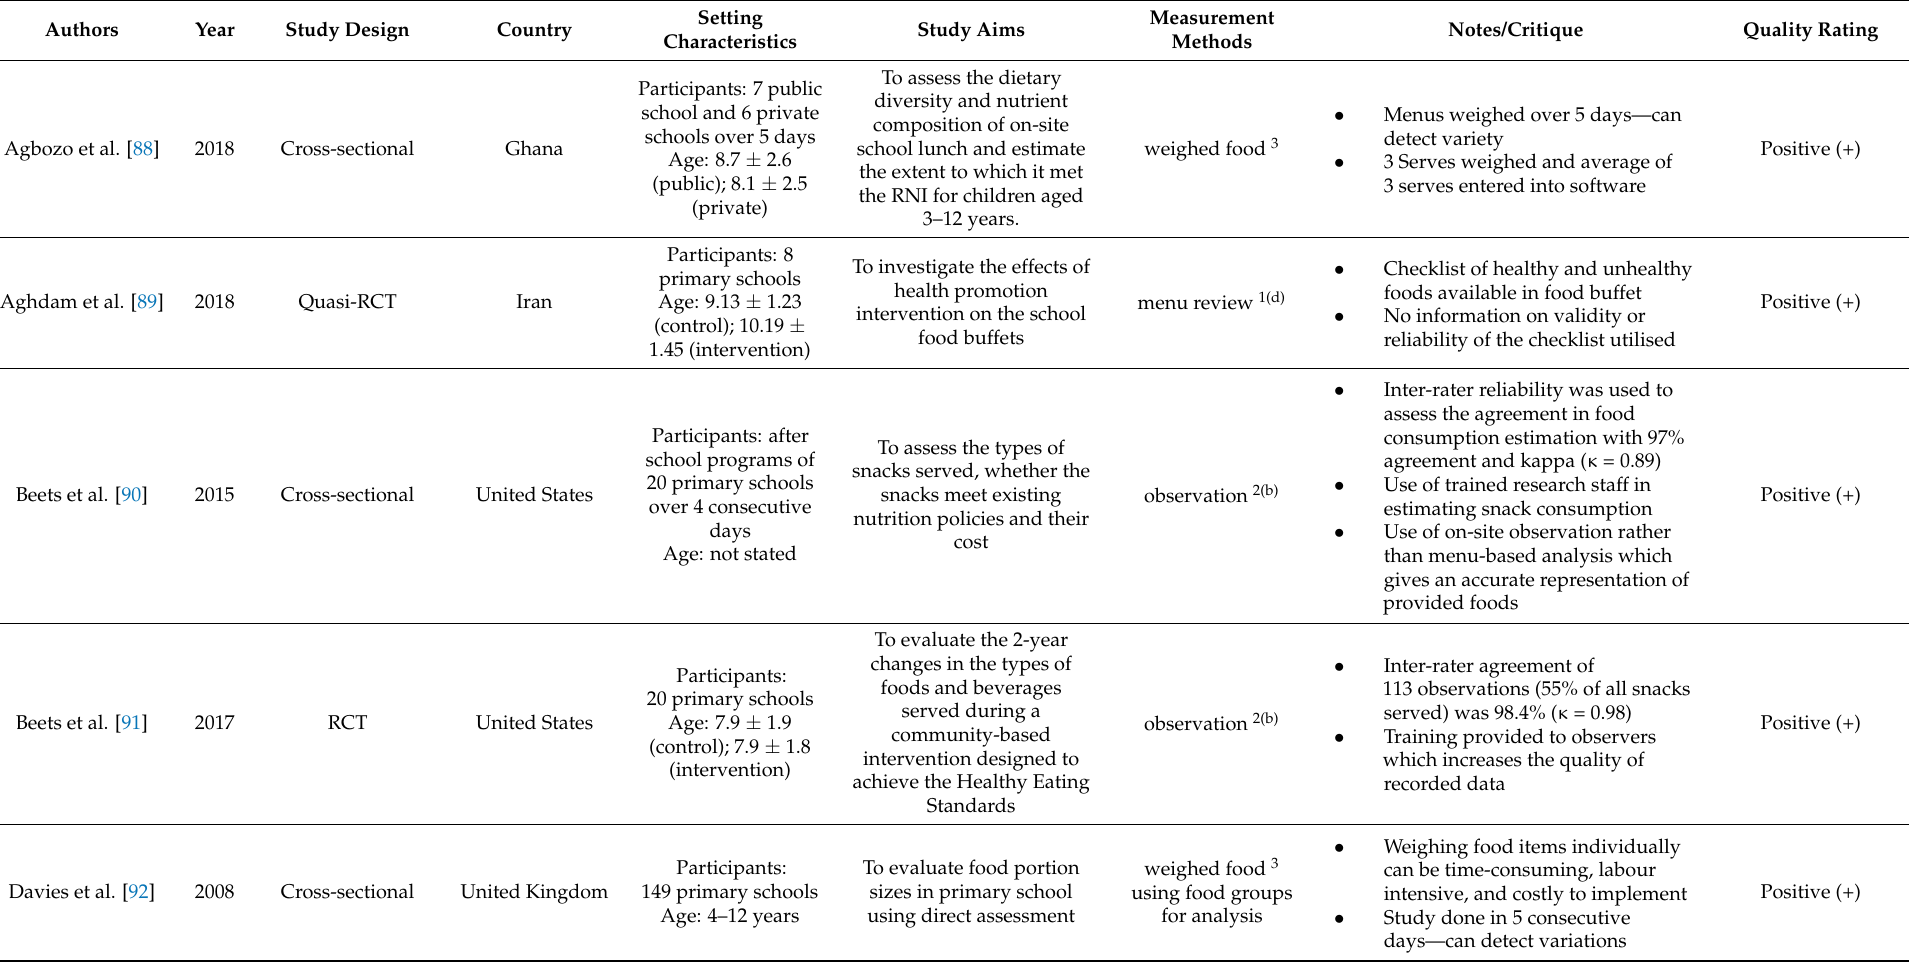
Table 2. Summary of studies measuring food provision in primary school settings ( n =